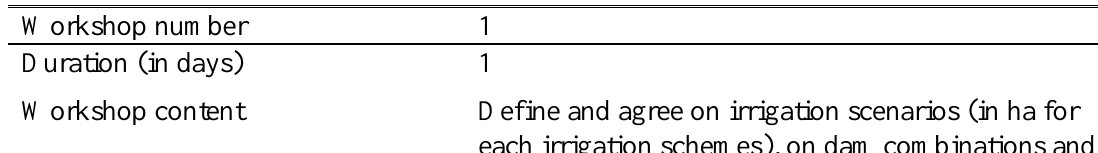
Table A1.4: Overview of the workshop undertaken for the Inner Niger Delta organised by Wetlands